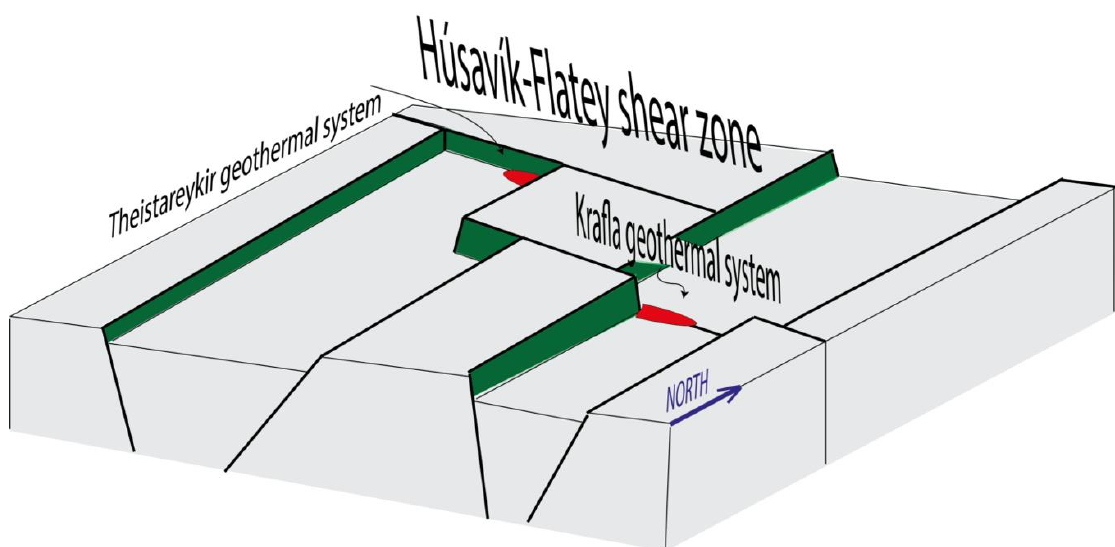
Figure 20. Conceptual structural model (not to scale) describing the relationships between geological structures and geothermal resources in the Krafla area, after Reference [86].